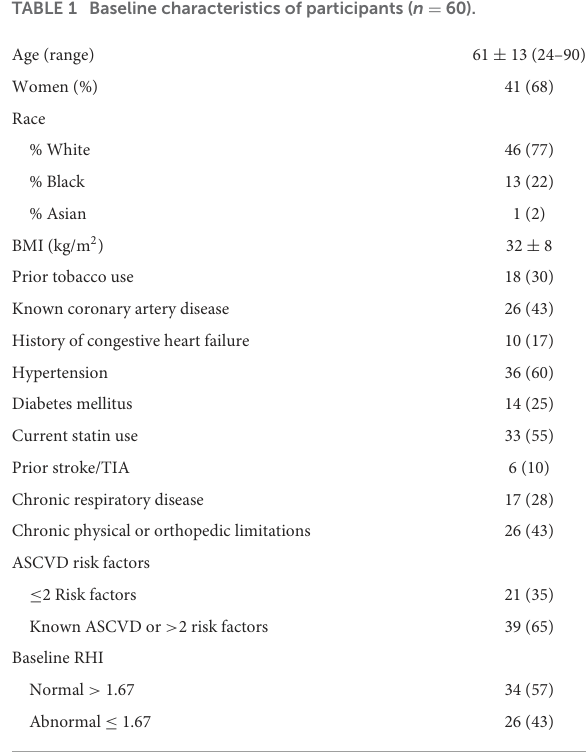
TABLE 1 Baseline characteristics of participants ( n =